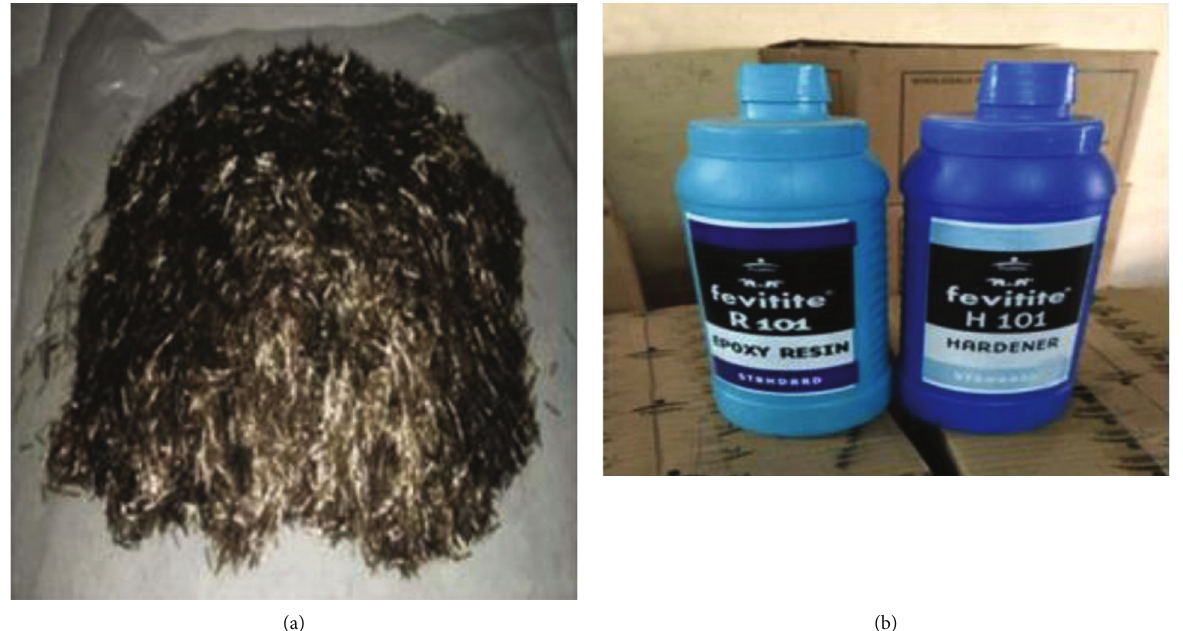
Figure 1: Main constitutions of epoxy composite (a) basalt fi ber and (b) epoxy resin with